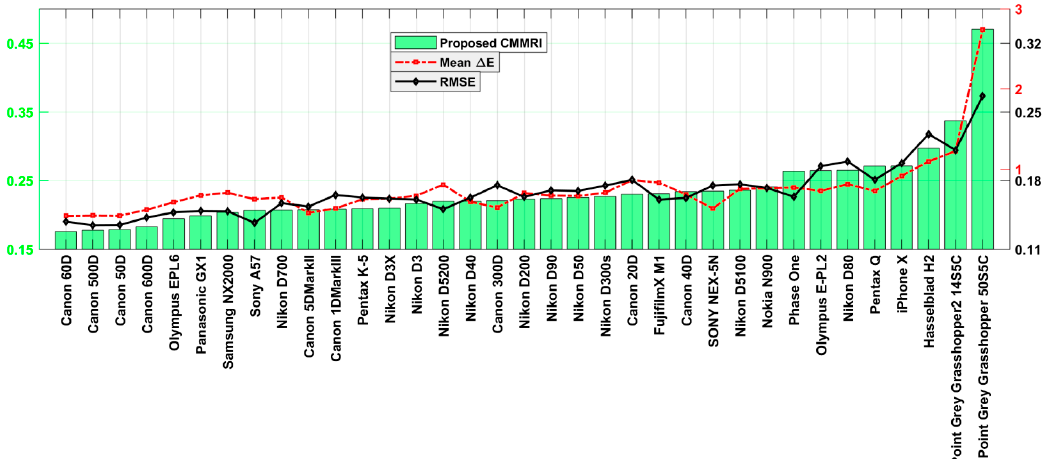
Figure 2. A Plot of the camera color accuracy measures Camera Metamer Mismatch Radii Index (CMMRI), mean ∆ E and root mean squared error (RMSE) for each camera sorted by increasing CMMRI. Lower scores are preferred. Note that this figure consists of three plots overlaid on one another. The scales of the ordinate axes of the plots are all different and they are also shifted from zero.